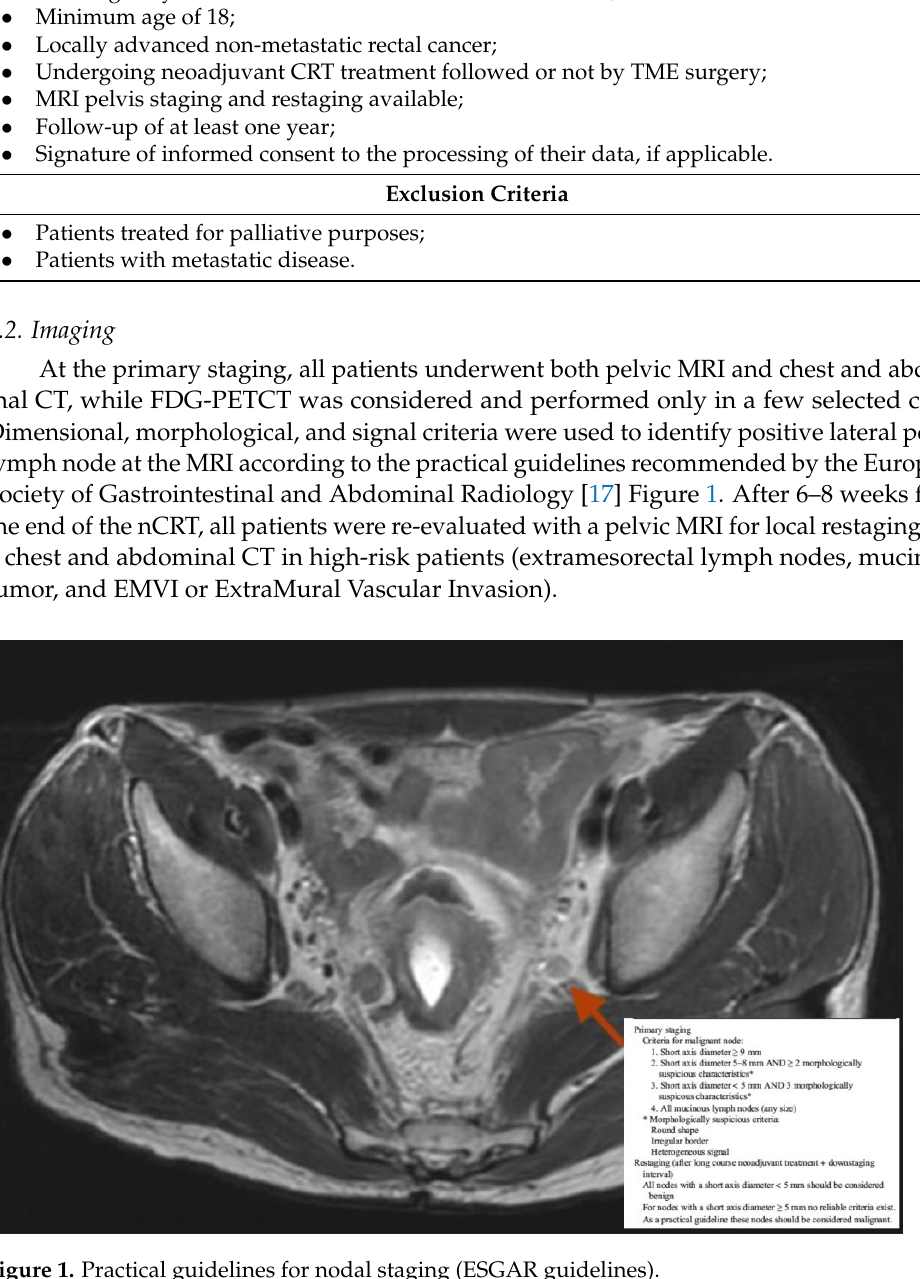
Figure 1. Practical guidelines for nodal staging (ESGAR guidelines).